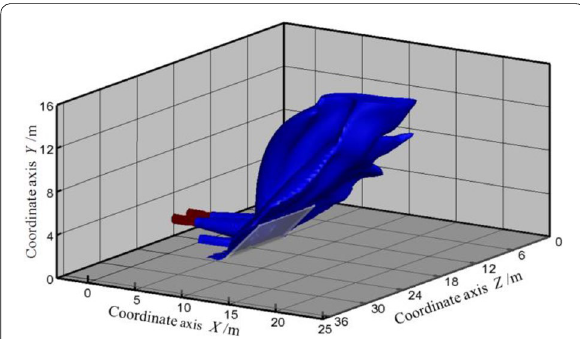
Figure 24 Velocity contour of 51 m/s in computational